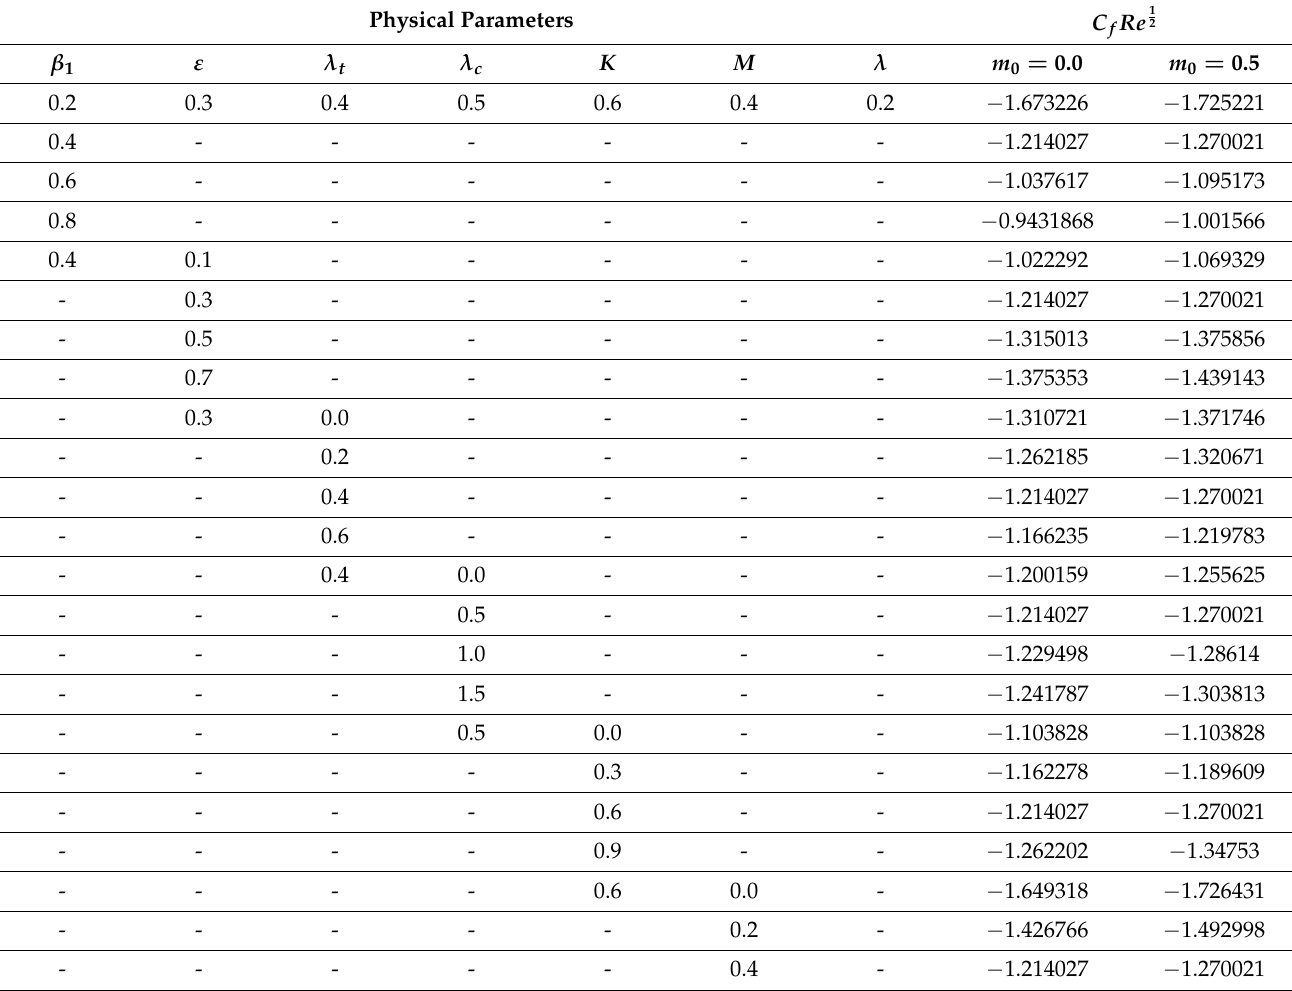
Table 3 is provided the comparison of results with two different techniques—bvp4c and NDsolve—for different values of β 1 and ε while the rest of physical parameters remained fixed, which was found to be in agreement with other results. Table 4 is presented the comparison of our results with Khan and Pop [34], Wang [35], and Gorla and Sidawi [36] when the rest of the physical parameters were considered zero. Our results are in agreement with decay results. Table 1. Numerical results of skin friction for different values of parameters. Physical Parameters